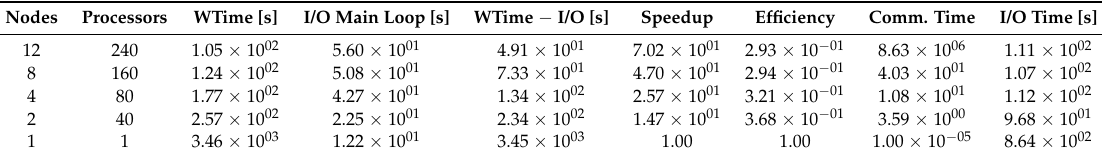
Table A4. Parallel performance of the medium-sized stratified seamount experiment (2000 × 100 × 100) in the COD system.